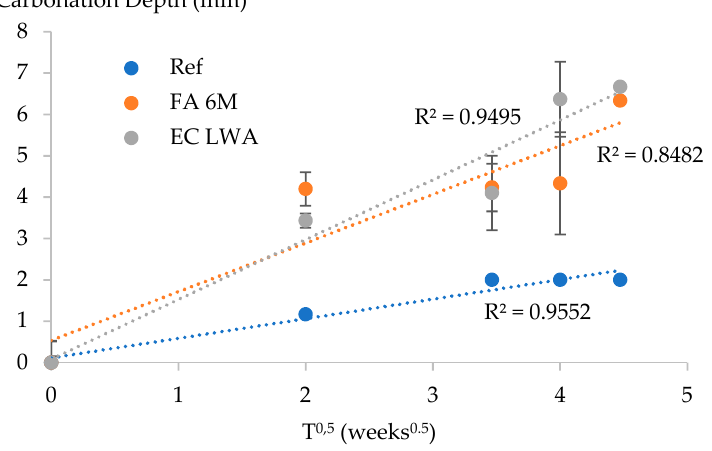
Figure 9. The evolution of the carbonation depth of the studied mortars. The linear regression is presented in dashed line.